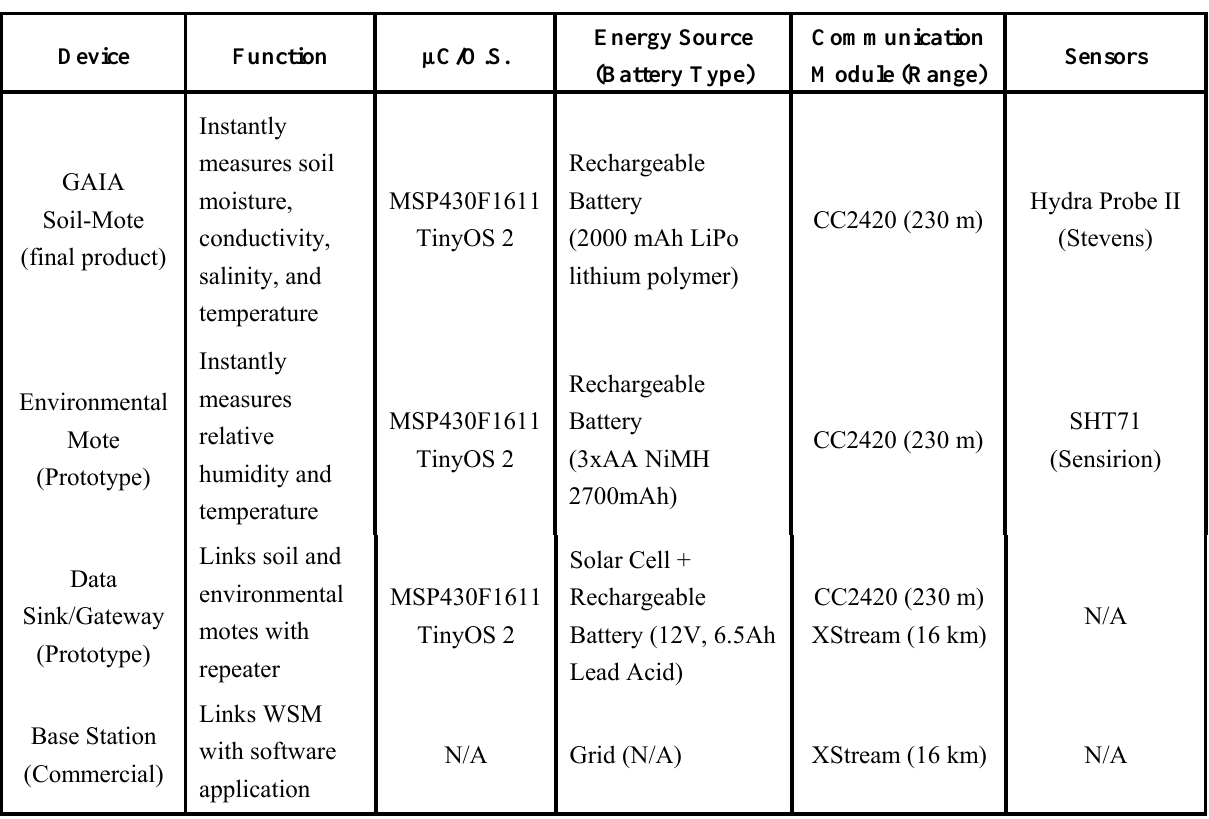
Table 1. Summary of devices used in the laboratory experiment.